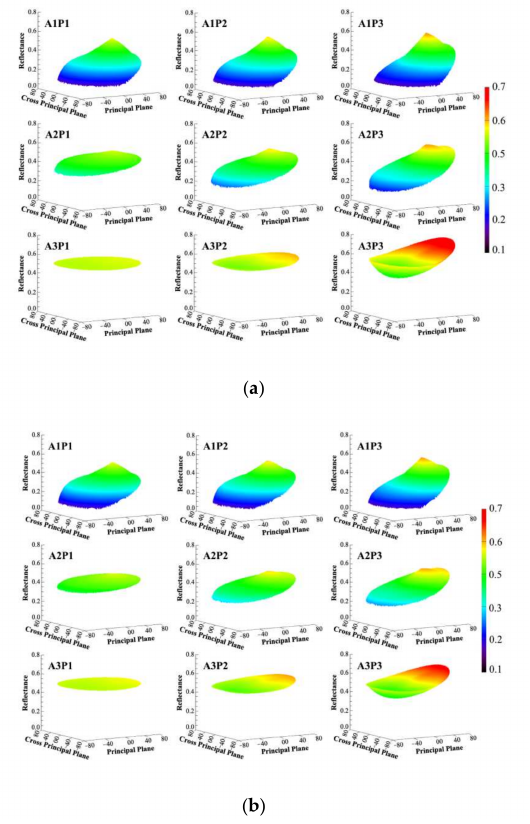
Figure 6. Three-dimensional plot of the shapes of BRDF archetypes in red band ( a ) and NIR band ( b ), assuming a solar zenith angle of 30 ◦ . Table 2. The parameters of each BRDF archetype in the red and NIR band archetype, where the isotropic parameters are normalized to